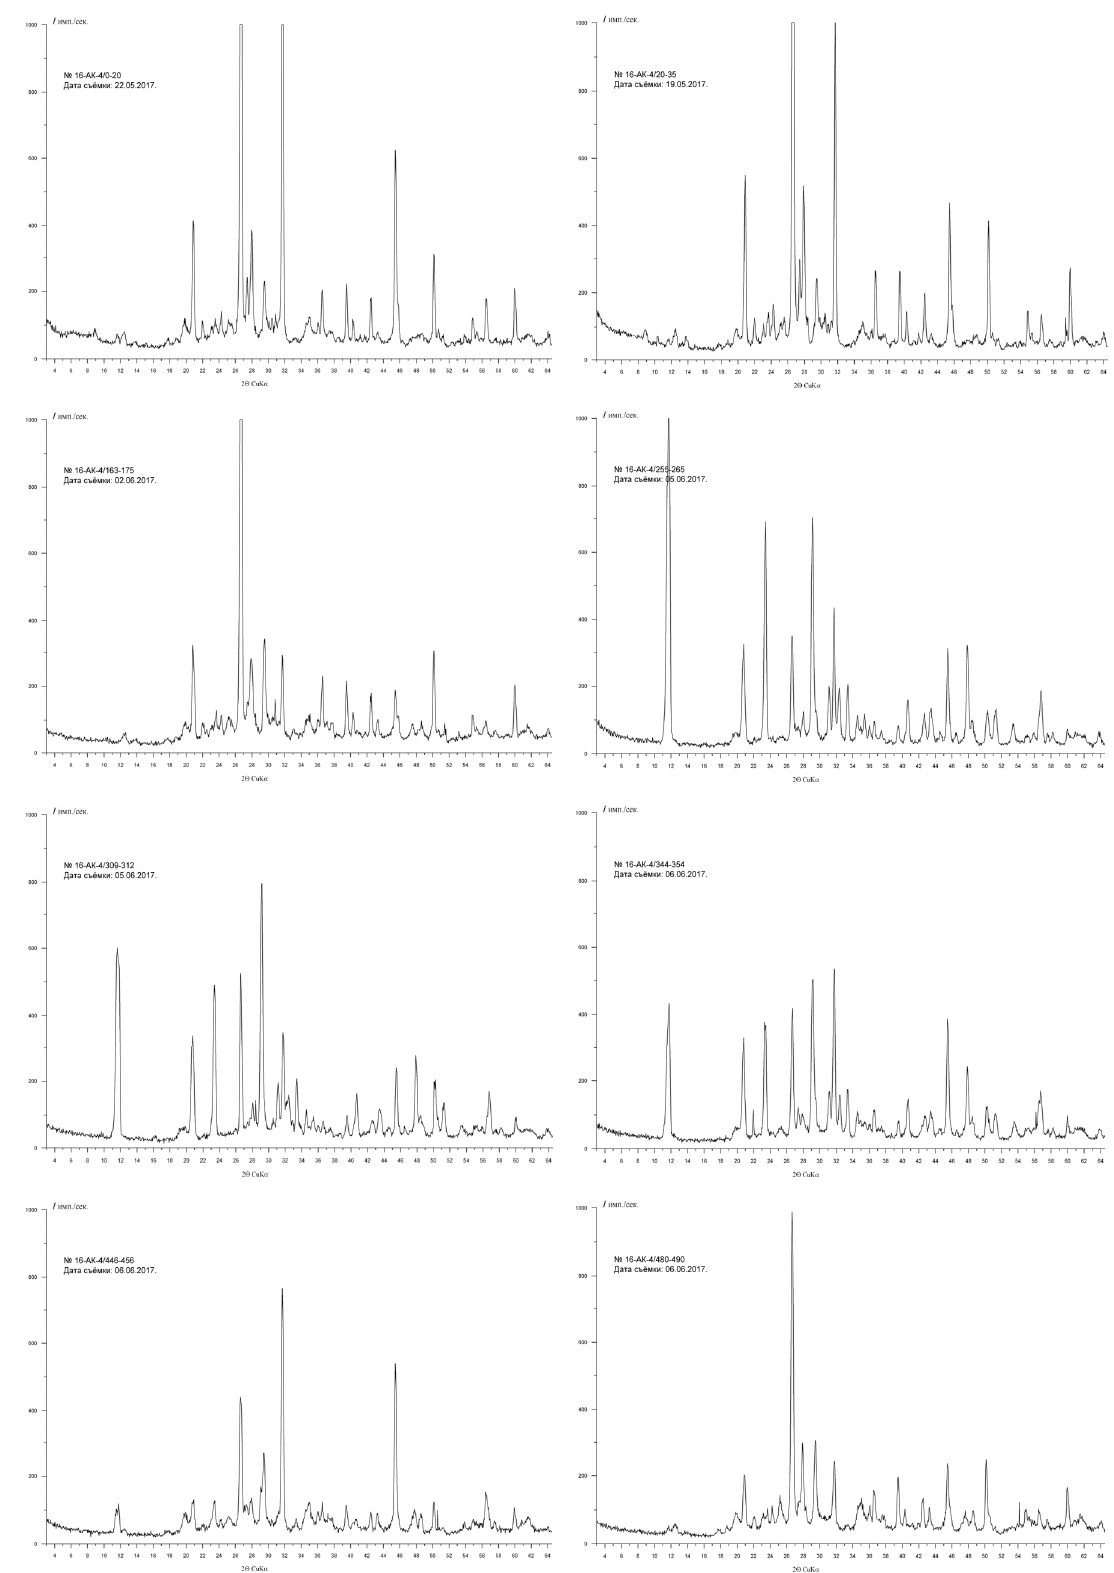
Figure 6. XRD spectra of Maloye Yarovoe lake’s sediments on di ff erent depths (the depth values are in